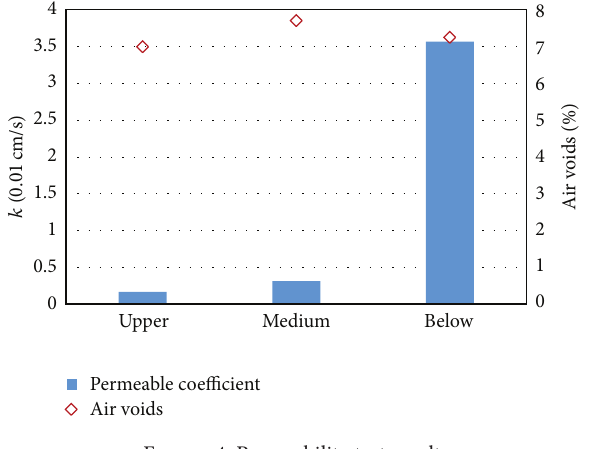
Figure 4: Permeability test